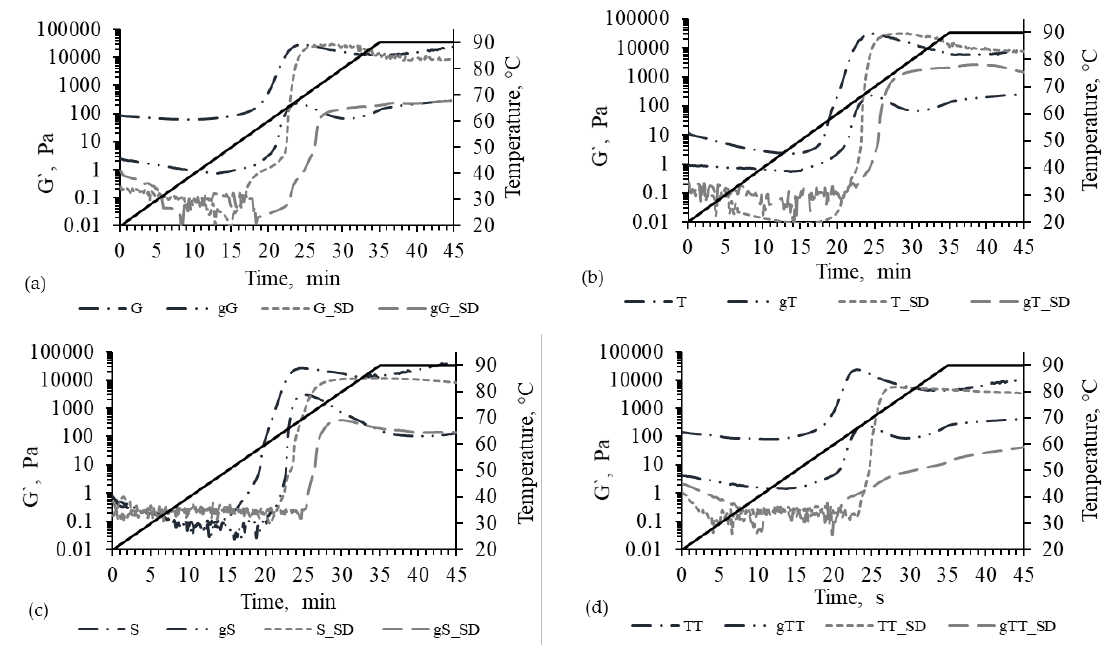
Figure 2. The evolution of the storage modulus of the suspensions and sourdoughs prepared with the wholemeal flours obtained by milling Gabriela ( a ), Trivale ( b ), Spelt ( c ) and Triticale ( d ) grains, during the temperature ramp test. Tests were performed on suspensions prepared using flours from raw (G, T, S and TT) or germinated grains (gG, gT, gS and gTT) and on corresponding sourdough samples (G_SD, T_SD, S_SD and TT_SD prepared out of G, T, S and TT flours, and gG_SD, gT_SD, gS_SD and gTT_SD prepared out of gG, gT, gS and gTT flours). The evolution of the temperature during the rheological test is represented with black full line.